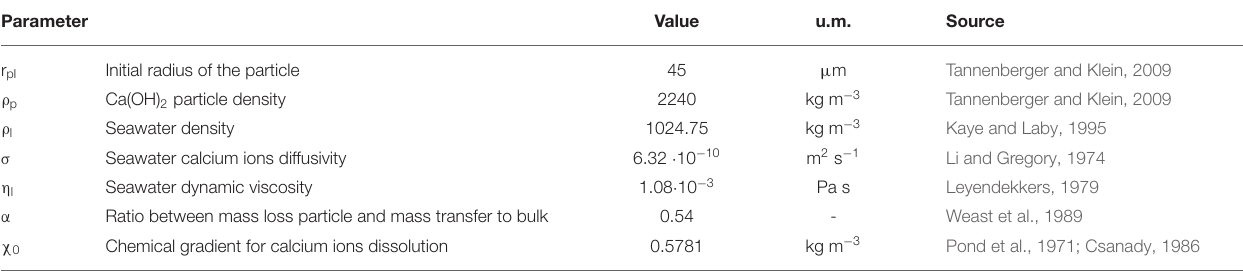
TABLE 5 | Constants quantities used in the one-dimensional bi-phase model.